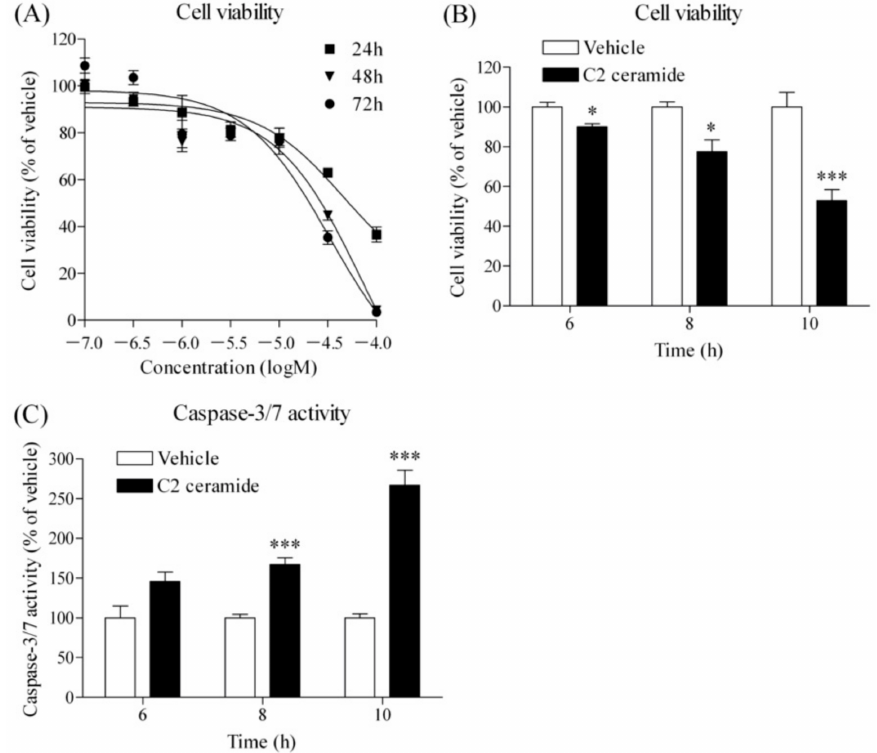
Figure 4. Effects of C2 ceramide on cell viability and caspase-3/7 activity in HSC-3 cells. ( A ) Effect of C2 ceramide on cell viability ( n = 3). Cells were preincubated with each concentration of C2 ceramide for 24, 48, and 72 h, and then cell viability was measured. Results are presented as a percentage of the vehicle control. Effect of 50 µ M C2 ceramide on cell viability ( B ) and caspase-3/7 activity ( C ) in HSC-3 cells ( n = 4). Cells were incubated with 50 µ M C2 ceramide for 6, 8, and 10 h, and then cell viability and caspase-3/7 activity were measured simultaneously. Results are presented as a percentage of the vehicle control. * p < 0.05 and *** p < 0.005 compared to the vehicle